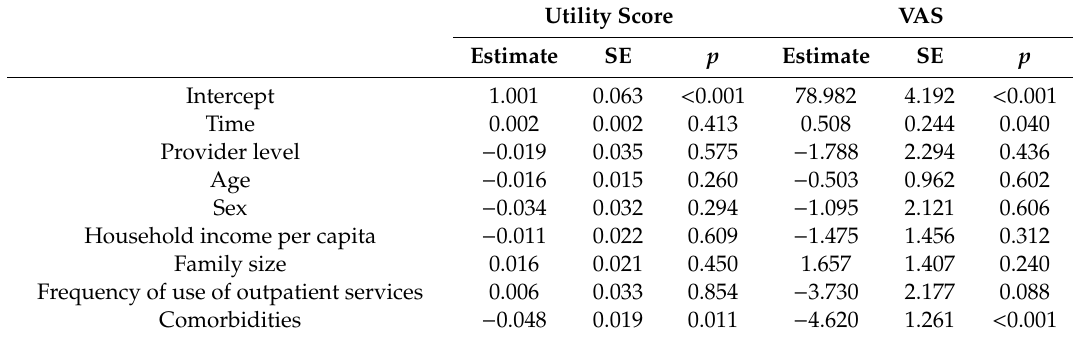
Table 3. Growth curve model of